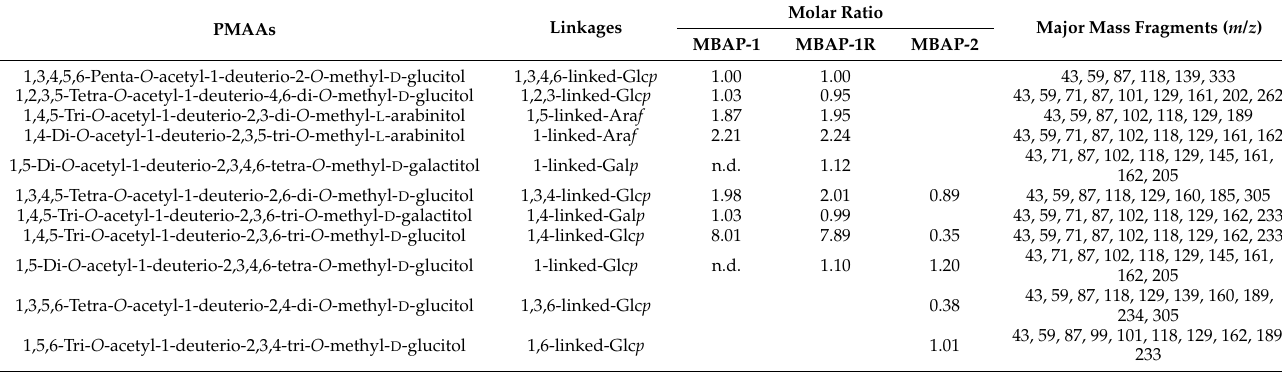
Table 3. The PMAAs results of MBAP-1, MBAP-1R and